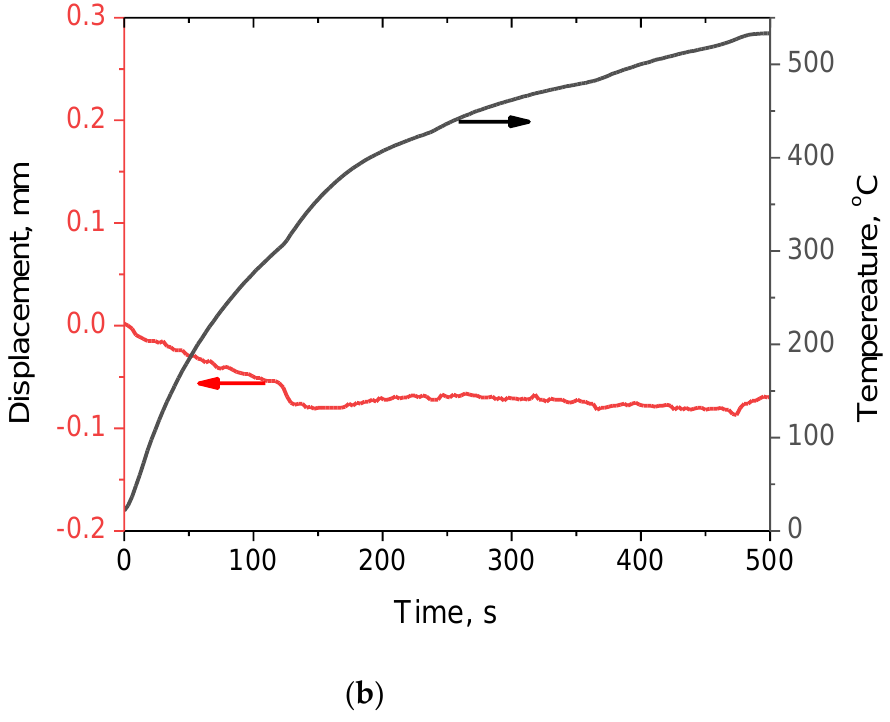
Figure 8. Temperature and displacement versus time during SPS of the glassy Fe 66 Cr 10 Nb 5 B 19 ( a ) and crystalline Fe 62 Cr 10 Nb 12 B 16 ( b ) alloy powders. Black lines, temperature; red lines, displacement.